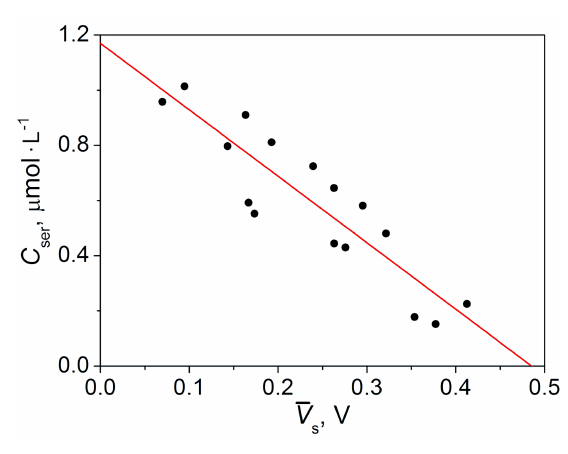
Figure 3: Dependence of the analytical concentration of serotonin C ser on the average response voltage in the area of the maximum corre- lation. Black dots correspond to the data from the medical tests and the red line is the result of the linear approximation, given by Equation 3.